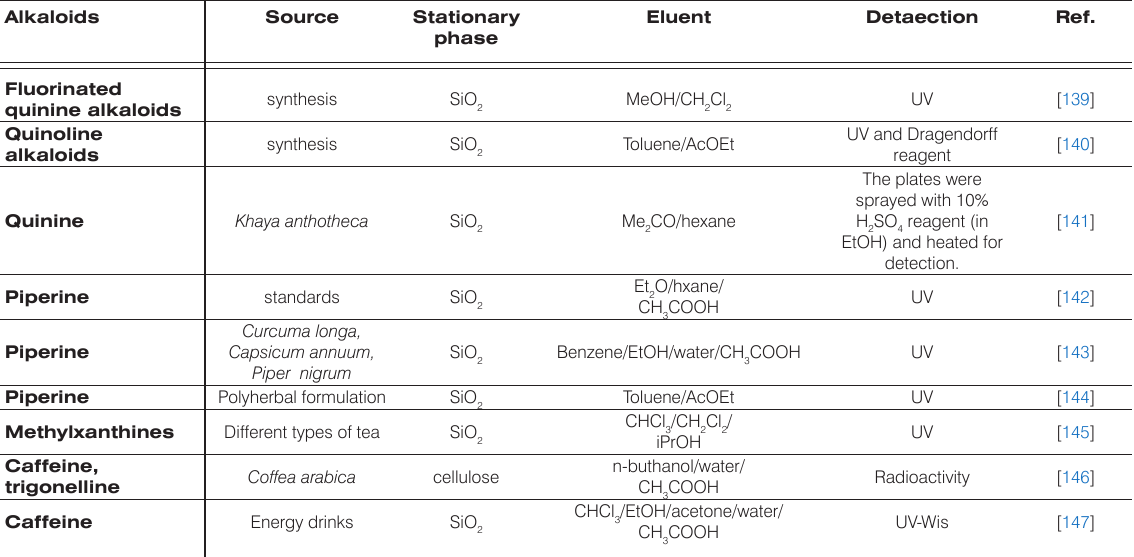
Table 1. Methods used for TLC of